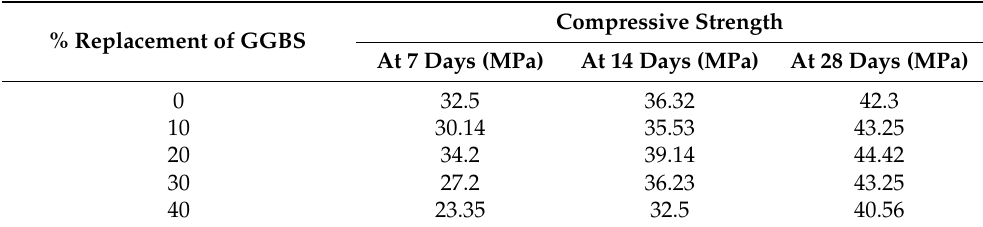
Table 7. Compressive strength values for an OPC concrete, with different ratios of GGBS (adapted from [52]).